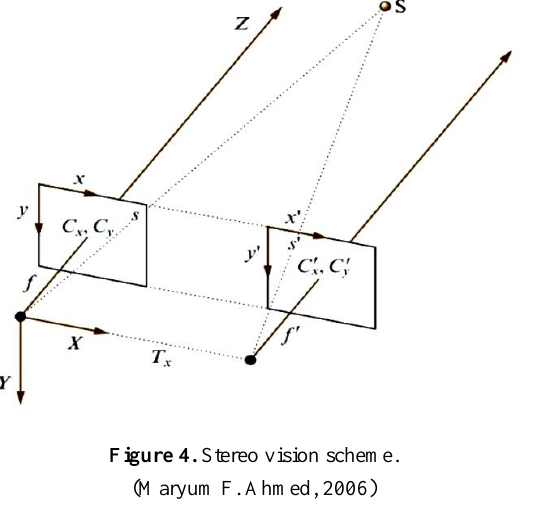
Figure 4. Stereo vision scheme. (Maryum F. Ahmed, 2006)